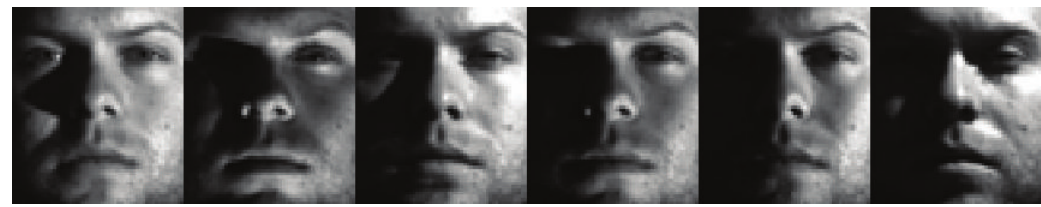
Figure 5: Some test samples from the Yale B face database from the same class.